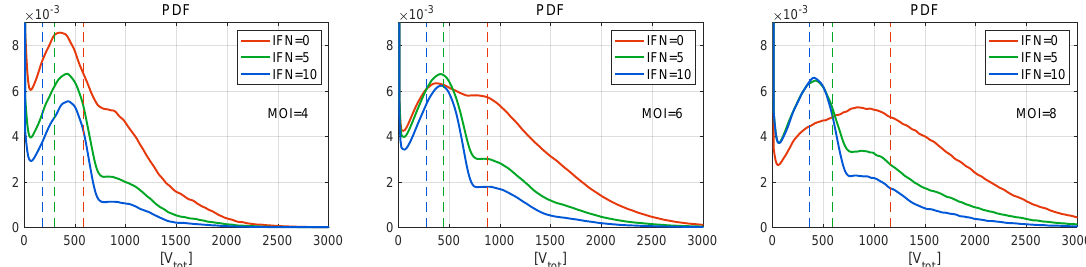
Figure 9. Normalised histograms (PDF) for [ V tot ]( t ) for MOI = 4 ( left ), 6 ( centre ), 8 ( right ), and for different values of initial interferon [ IFN e ]( 0 ) (the line colours are explained in the legend). The vertical dashed lines indicate the mean values. The curves demonstrate multiple peaks with the peak amplitude decaying faster with the number of produced virions. The right PDF tails look close to Gaussian distributions. The greater the MOI, the lower is the amplitude of the first